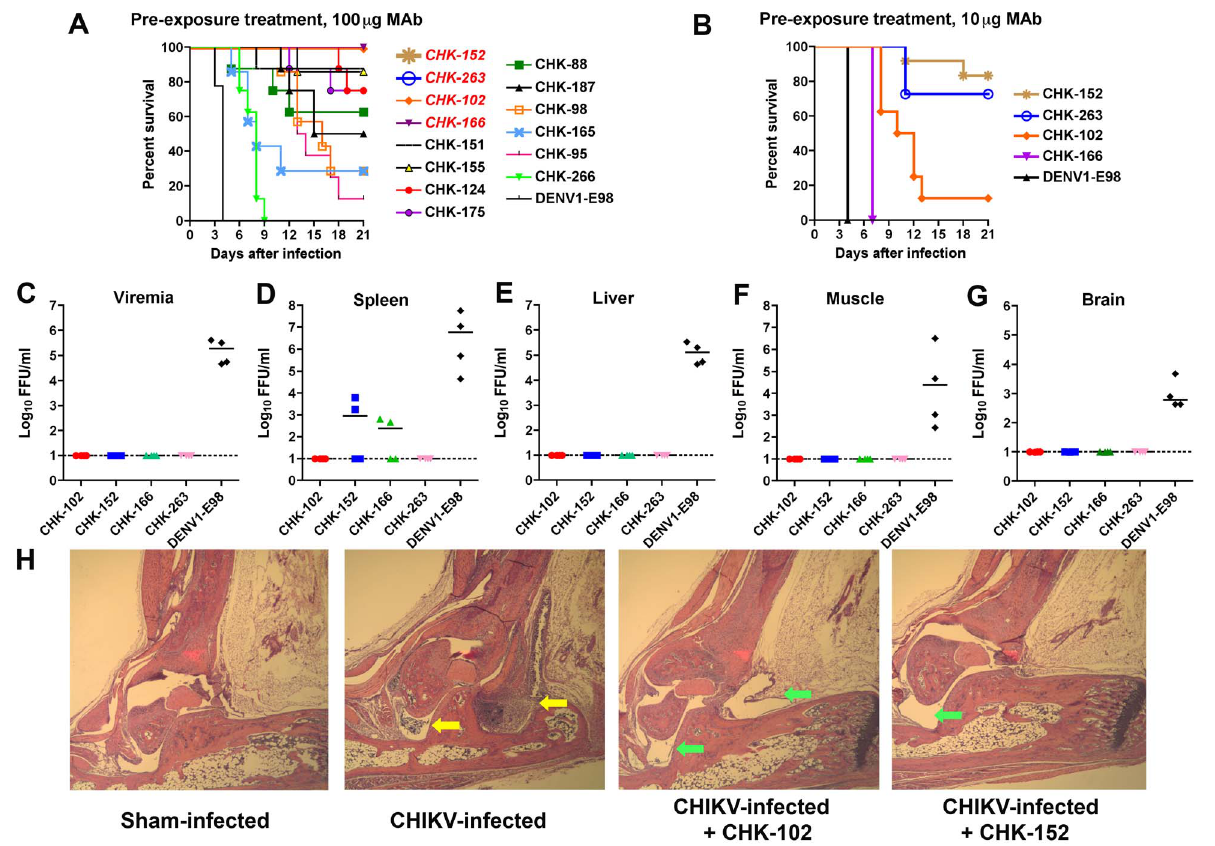
Figure 2. Efficacy of anti-CHIKV MAb prophylaxis. A . Six to eight week-old Ifnar 2 / 2 C57BL/6 mice were passively transferred 100 m g of the indicated MAbs via an i.p. injection one day before infection with 10 FFU of CHIKV-LR via a s.c. route. The percentage and number of surviving mice were as follows: DENV1-E98 (0%, 0 of 9), CHK-88 (62.5%; 5 of 8), CHK-95 (12.5%; 1 of 8), CHK-98 (28.6%; 2 of 7), CHK-102 (100%; 8 of 8), CHK-124 (75%; 6 of 8), CHK-151 (87.5%; 7 of 8), CHK-152 (100%; 8 of 8), CHK-155 (85.7%; 6 of 7), CHK-165 (28.6%; 2 of 7), CHK-166 (100%; 8 of 8), CHK-175 (75%; 6 of 8), CHK-187 (50%; 4 of 8), CHK-263 (100%; 8 of 8), or CHK-266 (0%; 0 of 8). MAbs italicized in red in the Figure provided 100% protection. B . Ifnar 2 / 2 mice were passively transferred 10 m g of MAb via an i.p. injection one day before infection with 10 FFU of CHIKV-LR via a s.c. route. The percentage and number of surviving mice were as follows: DENV1-E98 (0%; 0 of 7), CHK-102 (12.5%; 1 of 8), CHK-152 (83%; 10 of 12), CHK-166 (0%; 0 of 12), or CHK-263 (73%; 8 of 11). For ( A ) and ( B ) the survival curves were constructed from data of at least two independent experiments. All anti-CHK MAbs provided statistically significant protection in the percentage of surviving animals or mean survival time compared to the control DENV1-E98 MAb ( P , 0.05). C–G . Viral burden in MAb-treated Ifnar 2 / 2 mice. Animals were passively transferred 100 m g of the indicated MAbs (CHK-102, CHK-152, CHK- 166, CHK-263, or isotype control DENV1-E98) via an i.p. injection one day before infection with 10 FFU of CHIKV-LR via a s.c. route. Two days later, viremia ( C ) and tissues ( D , spleen; E , liver; F , muscle; and G , brain) were harvested and infectious virus was titrated by focus-forming assay. Results are pooled from two independent experiments ( n =4 mice per group). The dashed line indicates the limit of detection of the assay and the solid bar indicates the median values. All viral burden results with CHK-102, CHK-152, CHK-166, and CHK-263 were statistically different ( P , 0.02) from those obtained with DENV1-E98, as analyzed by the Mann-Whitney test. H . Four week-old female WT C57BL/6 mice were sham-treated or administered 100 m g of CHK-102 or CHK-152 via an i.p. route. 24 hours later, mice were infected with 100 PFU of CHIKV-SL 15649 and at day 10, virus-induced pathology in the foot and ankle joint was assessed. ( Outer left ) Sham-infected, ( middle left ) CHIKV infected and sham-treated, ( middle right ) CHIKV- infected and CHK-102 treated, and ( outer right ) CHIKV infected and CHK-152 treated. Shown are representative images after hematoxylin and eosin staining from at least 3 mice per group at 100 6 magnification. Yellow and green arrows indicate regions of inflammation or normal joints, respectively.